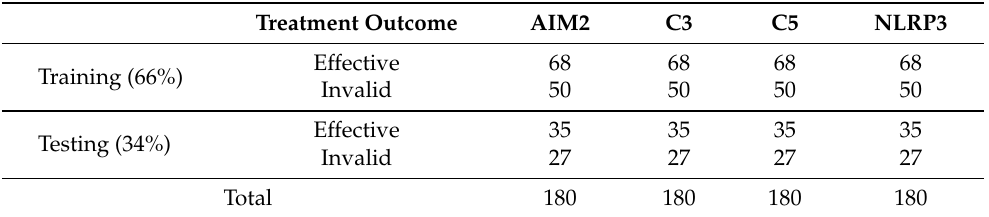
Table 2. Data distribution of the collected four datasets w.r.t. immune-related proteins for training and testing for the first